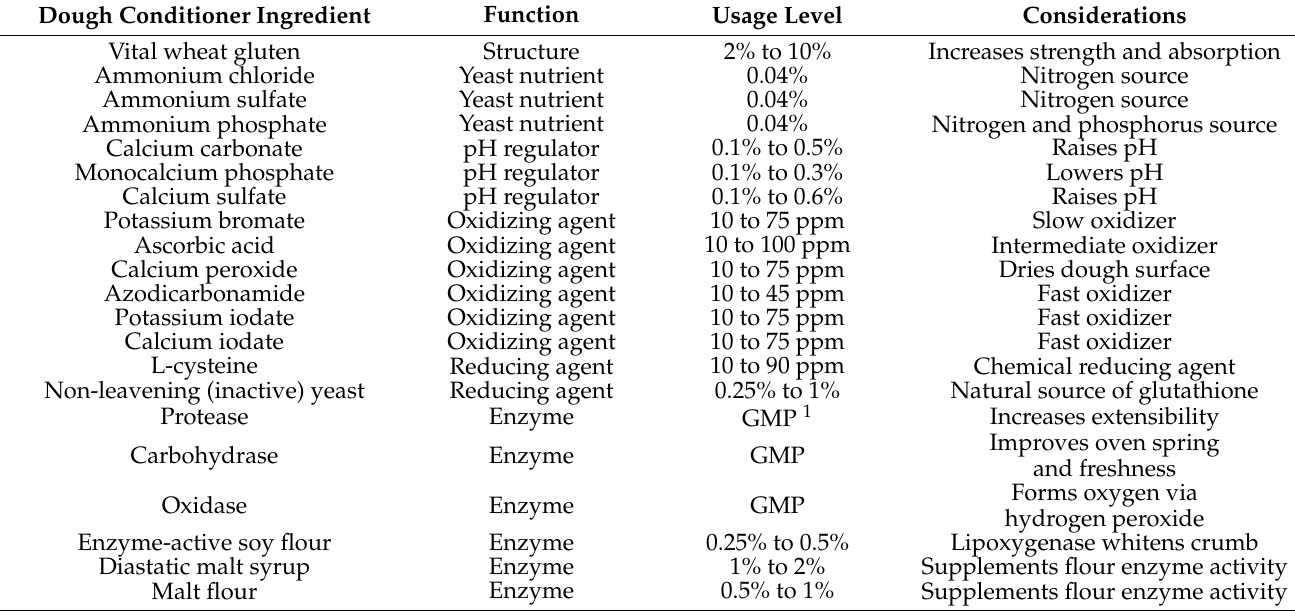
Table 1. Dough-conditioning agents with functions and use levels